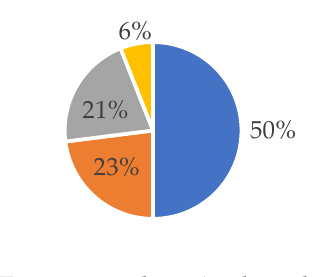
Figure 2. Share of GHEX studies by type, numbers adapted from [4].